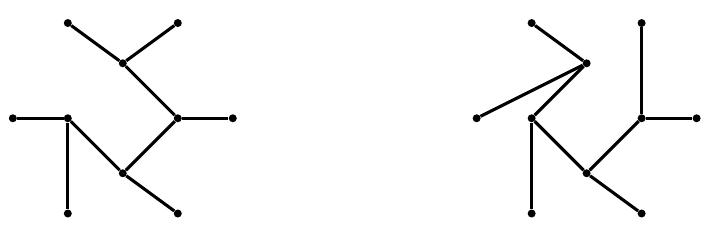
Figure 1 . Two di(cid:11)erent representations of the same six-point correlation function leading to seemingly new constraints on the OPE coe(cid:14)cients.